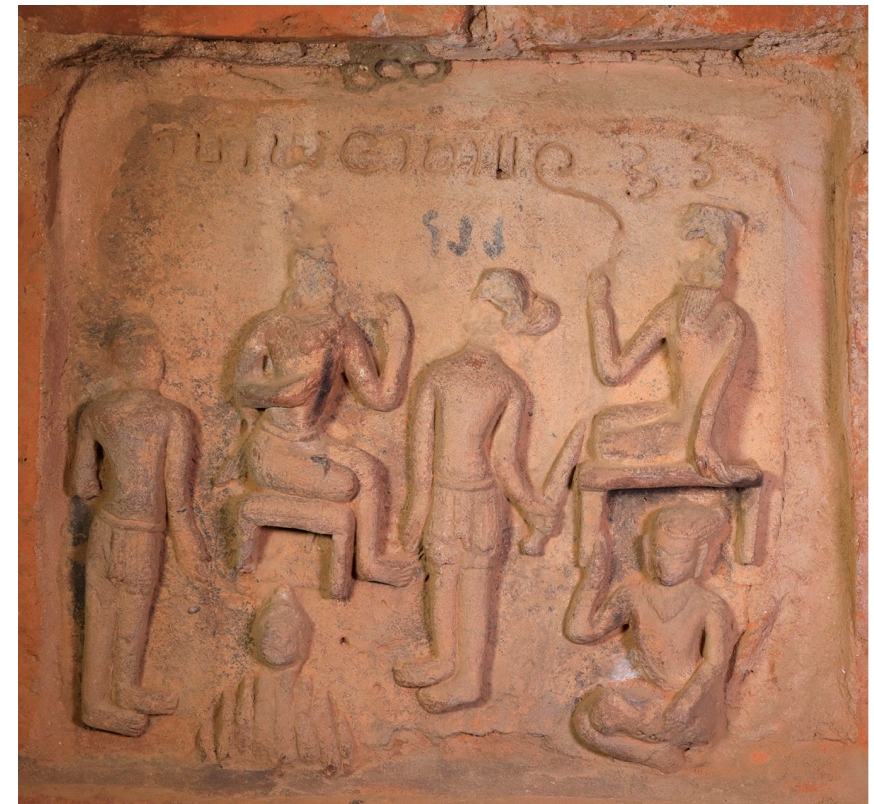
Figure 9. Pagan, Hpetleik Stupa, 11th Century. Jataka 422. Devadatta sinking into the earth, usually shown by a fire bursting from the underground, only the king’s head remaining visible.